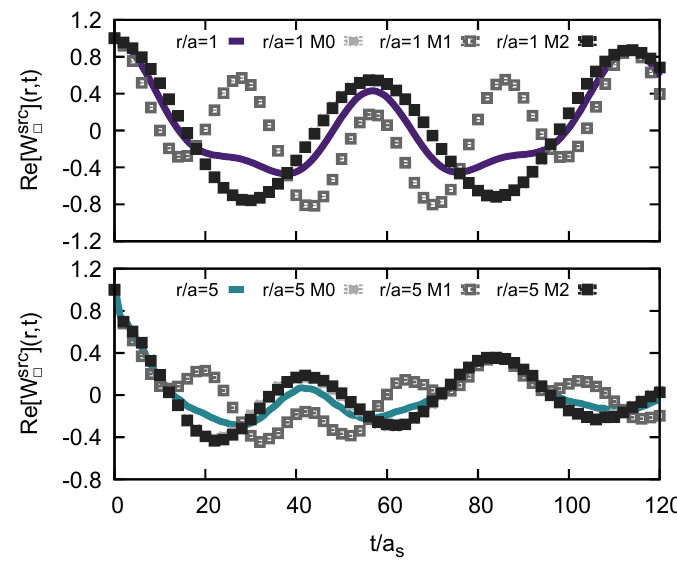
Figure 9 . Comparison of the real-part of the Wilson loop trace h W i (solid) in coordinate space to the modified traces h M i W i (gray symbols) at the shortest distance r/a = 1 (top) and an interme- diate distance r/a = 5 (bottom). We find that their values do differ beyond statistical errors. The trace based on the matrix M 1 , which is used in the Gauss law exhibits a different evolution than those based on M 0 and M 2